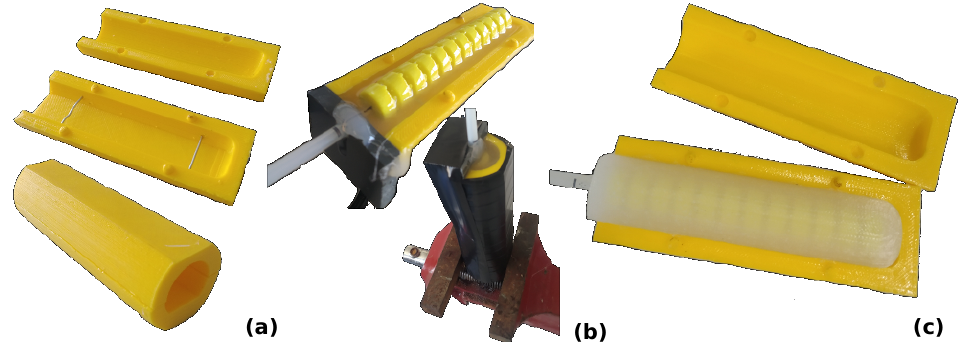
Figure 5. The manufacturing process to include silicone rubber around the 3D printed actuator: ( a ) the molds printed using PLA material, ( b ) the curing of two-component liquid silicone rubber (EcoFlex 00-30 from Smooth-on Inc), and ( c ) the resulting multi-material soft